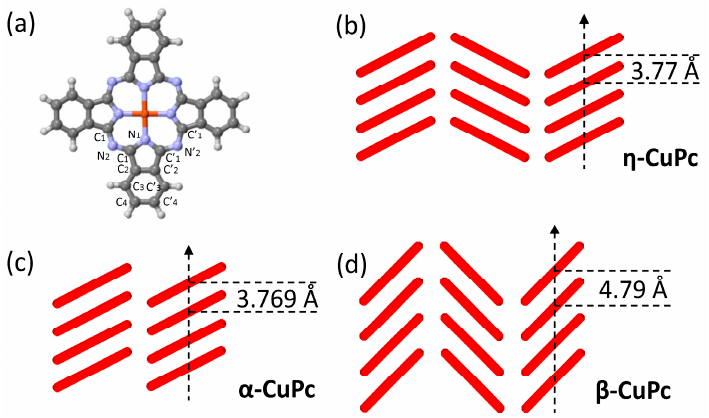
Figure 1. ( a ) Schematic of the molecular structure of CuPc, where H atoms are in light grey, C in grey, N in blue, and Cu in red. Schematic packings of the η -, α -, and β -phases of CuPc are shown in ( b – d ), respectively. Notice that a herringbone-packing motif in the η - and β - phases, but a parallel-packing motif in the α -phase. motif in the α